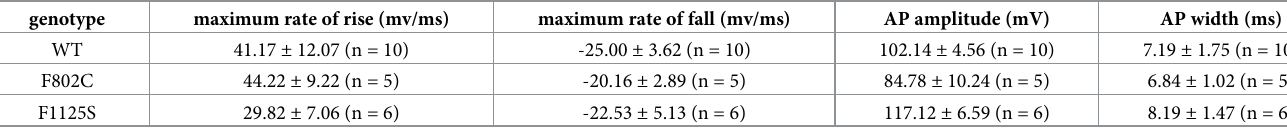
Table 3. Parameters of action potential in DRG of WT and mutants mice.